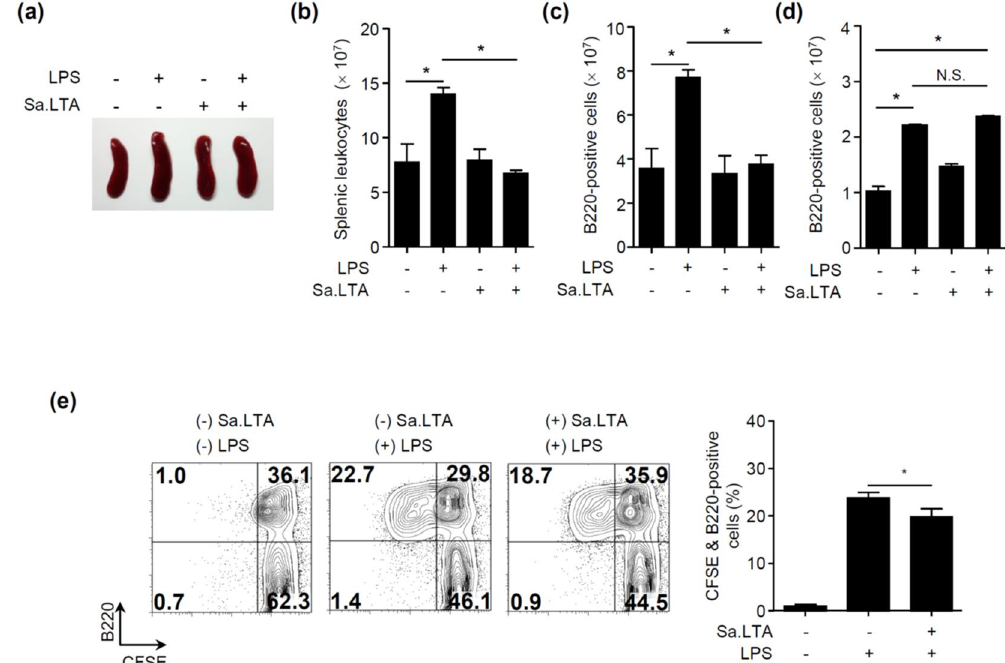
Figure 5. Staphylococcal LTA inhibits LPS-induced B cell proliferation in vivo . C57BL/6 mice (n = 3 per group) were i.p . injected with LPS (50 μ g/mouse) and/or Sa.LTA (300 μ g/mouse). After 48 h, spleens were